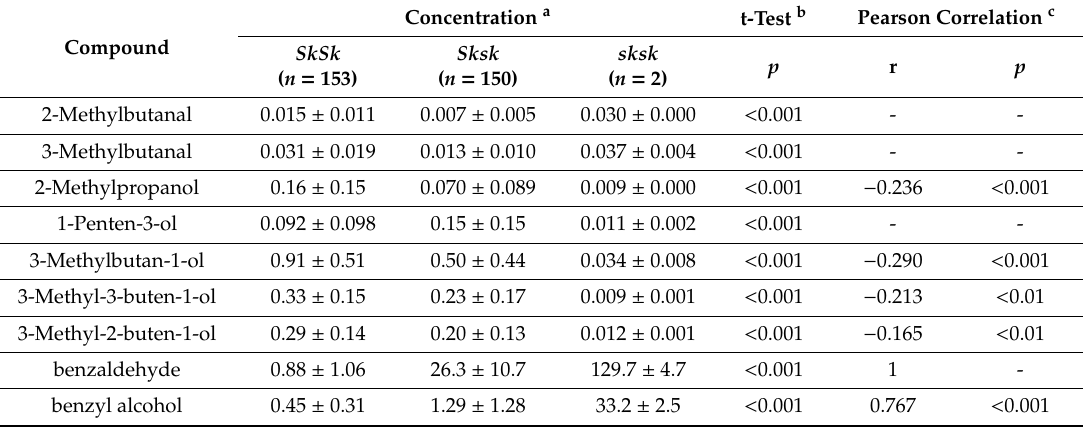
Table 3. Occurrence of main volatile compounds showing significant di ff erences between genotypes ( SkSk, Sksk ) by Student’s t-test, presented as mean ± standard deviation. Correlation of volatiles with benzaldehyde (in SkSk, Sksk samples) are also shown. Concentration a t-Test b Pearson Correlation Compound